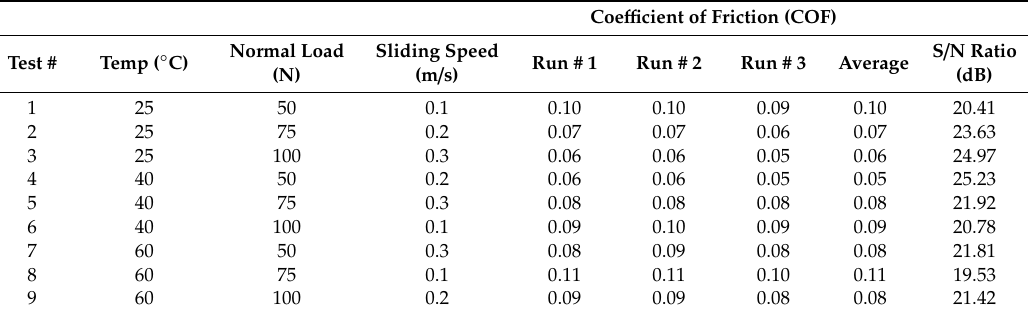
Table 6. Experimental results for COF and the corresponding S / N